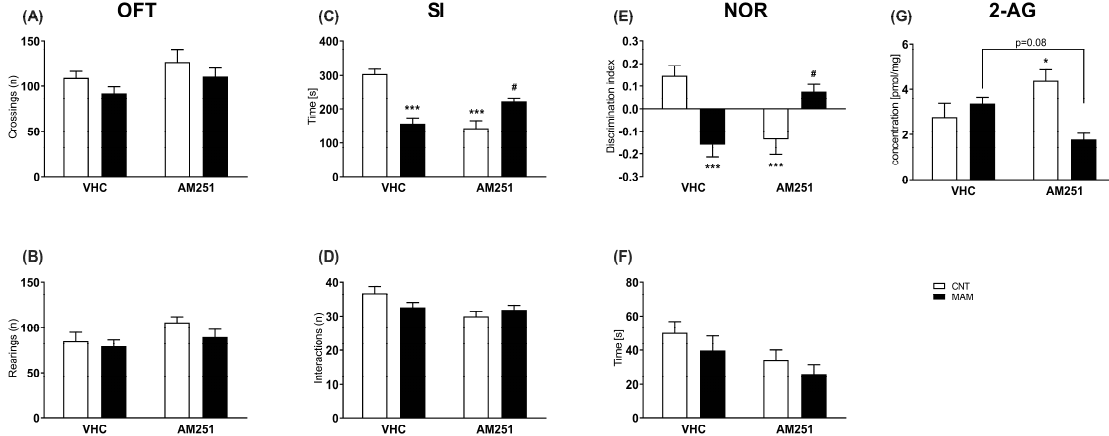
Figure 4. Effects of early pharmacological blockade of cannabinoid CB1 receptor on MAM rats at adulthood. Data are presented as means ± S.E.M ( n = 7–12) of ( A , B ) locomotor activity in the OFT, ( C , D ) social behavior in the SI, ( E , F ) cognitive performance in the NOR, and of ( G ) ( n = 3–5) 2-AG content in the PFC. * p < 0.05 and *** p < 0.01vs. CNT/VHC; # p < 0.05 vs. MAM/VHC.